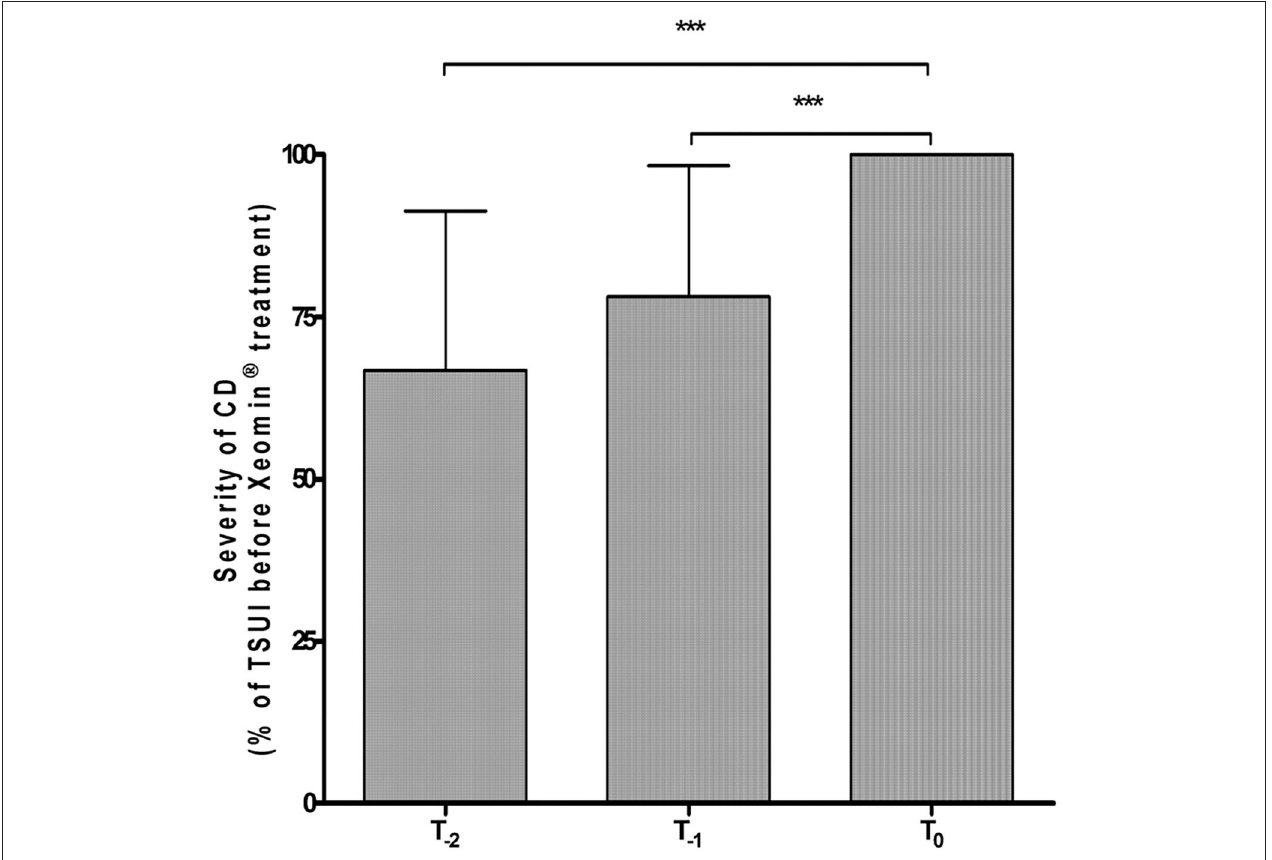
FIGURE 1 | Highly significant worsening of mean normalized TSUI score during the last 6 months under previous BoNT treatment before the first incoBoNT/A injection. *** p < 0.001. T-2 = Mean normalized TSUI score before the second last BoNT injection prior to incoBoNT/A treatment; T-1 = Mean normalized TSUI score before the last BoNT injection prior to first incoBoNT/A treatment; T0 = normalized baseline TSUI score ( = 100%) just before first incoBoNT/A treatment. TSUI-scores at T-2 and T-1 were normalized to baseline TSUI-score at